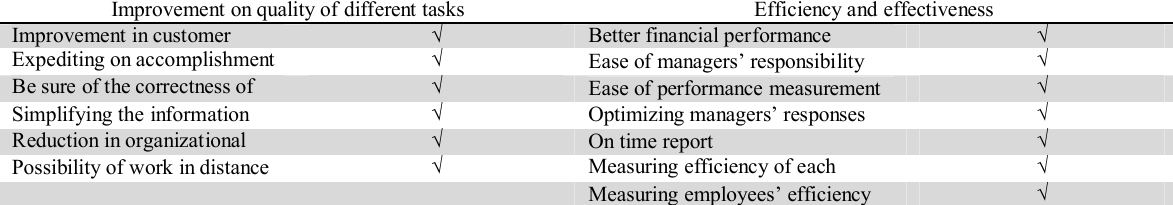
The summary of different sub-components of the survey in terms of execution strategy Improvement on quality of different tasks Efficiency and effectiveness Improvement in customer √ Better financial performance satisfaction measurement √ Ease of managers’ responsibility of tasks Be sure of the correctness of